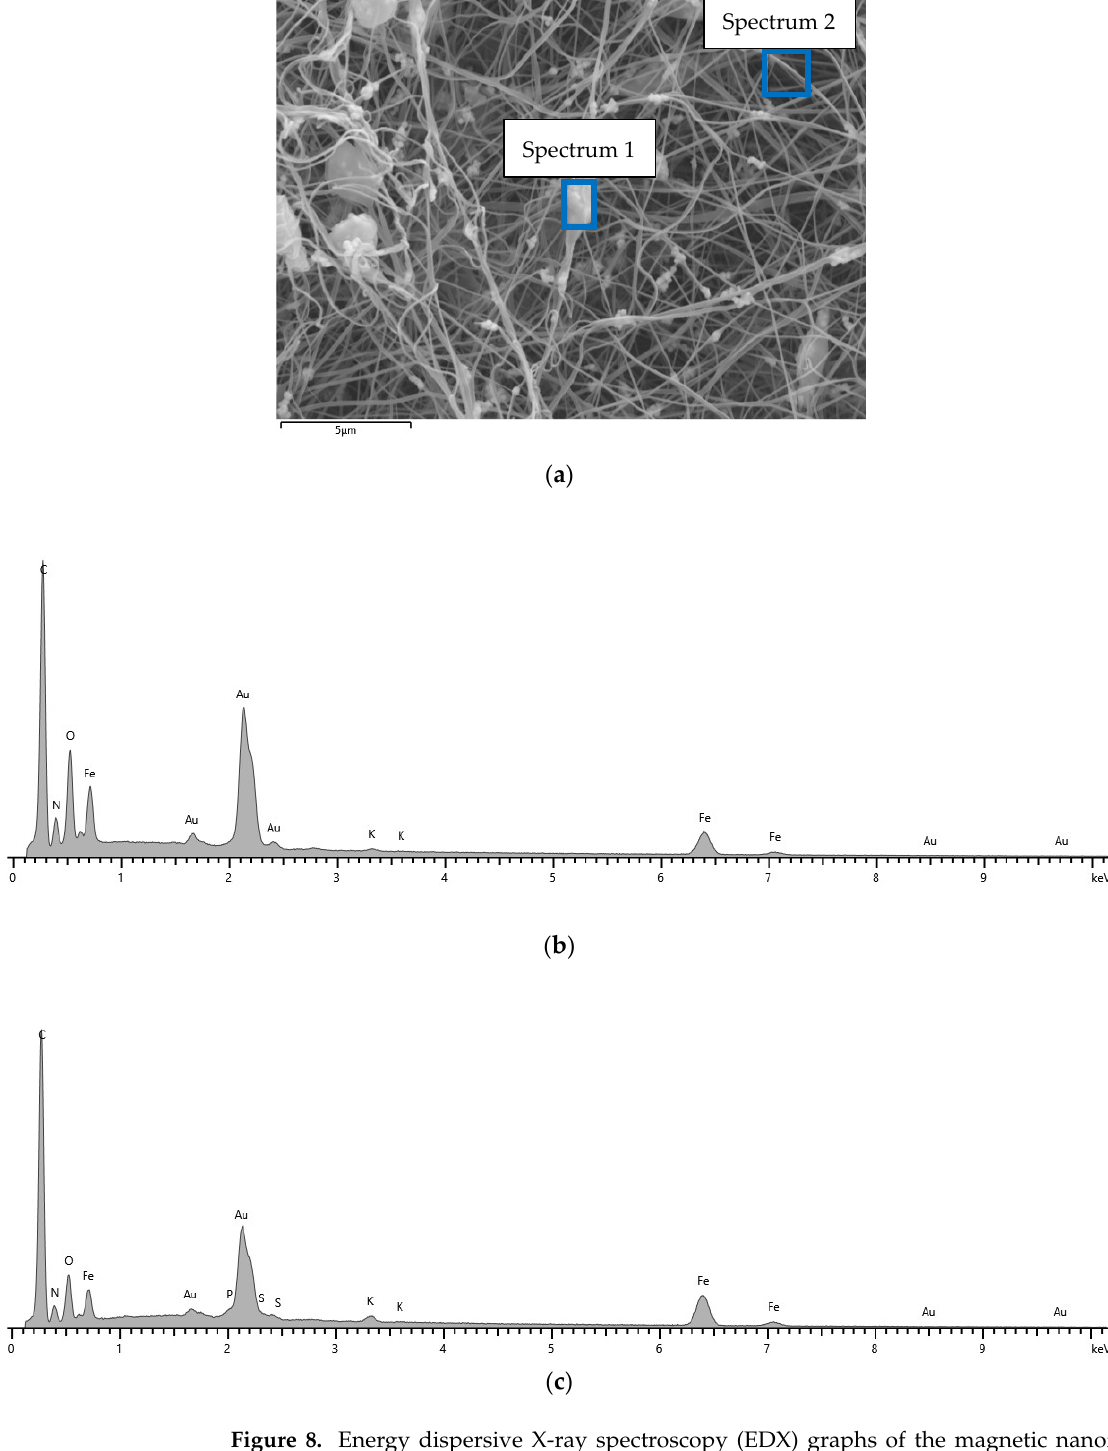
Figure 8. Energy dispersive X ‐ ray spectroscopy (EDX) graphs of the magnetic nanofiber mats: ( a ) 16 wt% PAN with 65 kV voltage and 40 min ultrasonic bath; ( b ) Spectrum 1—spot on the bead; ( c ) Spectrum 2—spot on the nanofiber.